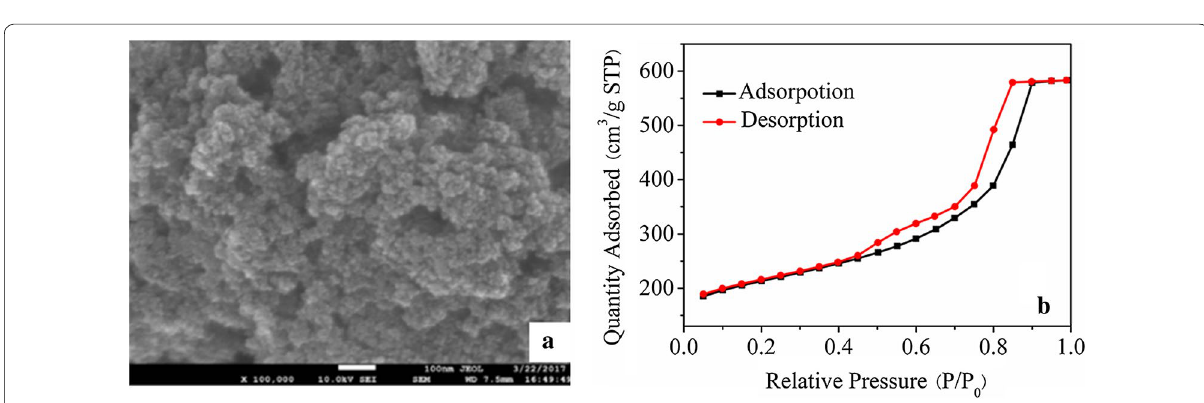
Fig. 1 a SEM image and b N 2 adsorption–desorption isotherms of